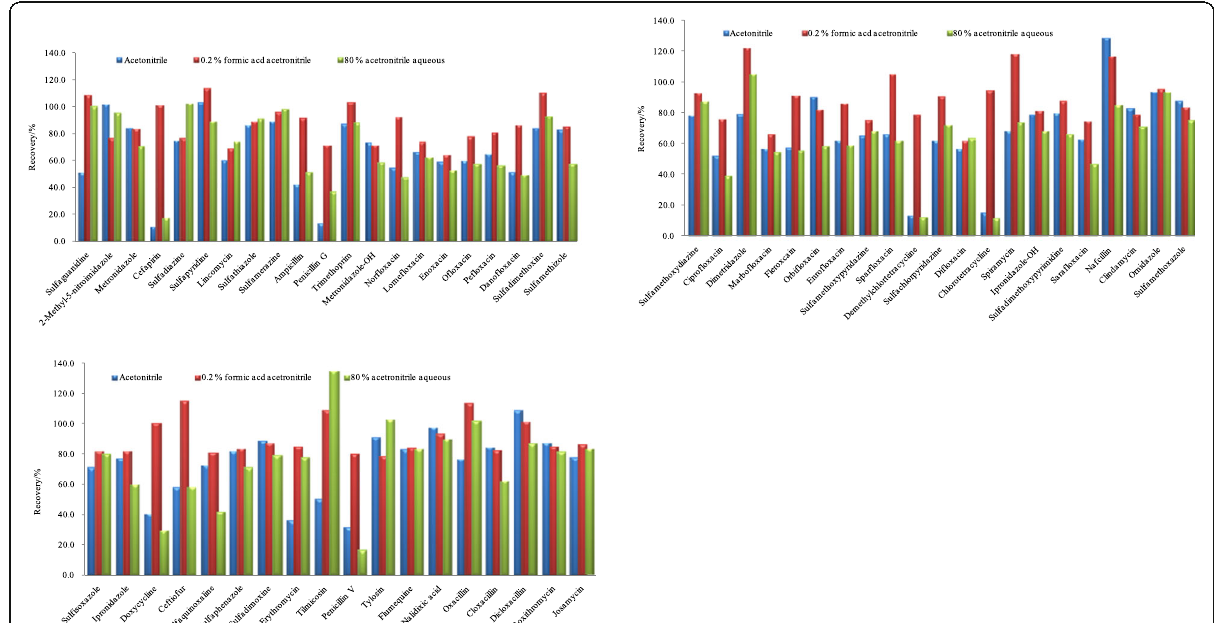
Fig. 3 Effect of different extraction solutions on the extraction properties (experiments were performed at spike levels of 10 g/kg for 60 veterinary antibiotic